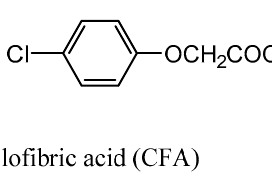
Figure 1. Example of previously studied aryloxyalkanoic acid derivatives.